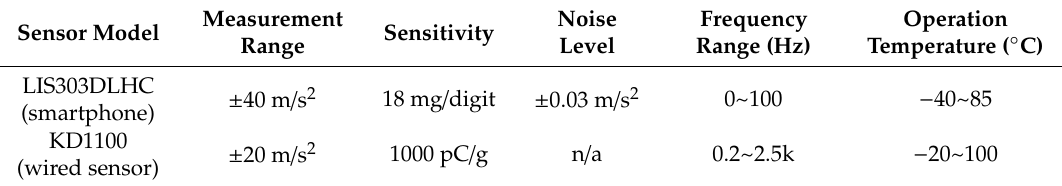
Table 6. Technical specifications of smartphone vibration sensor and wired